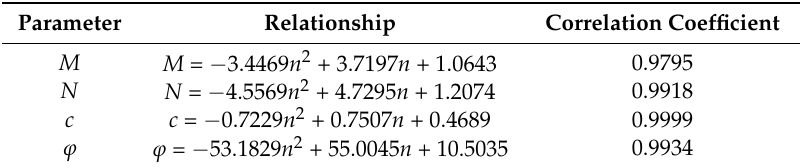
Figure 12. Relationship between the strength parameter and Talbot index of CPB specimens. Table 7. Relationship between the strength parameter and Talbot index.